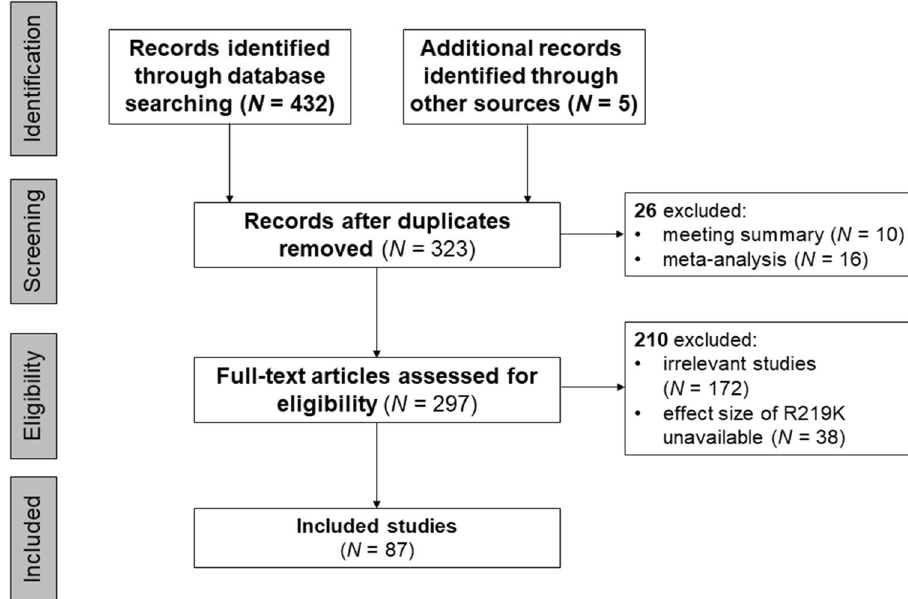
Figure 1. A literature reviewing for the relationship between R219K and lipid